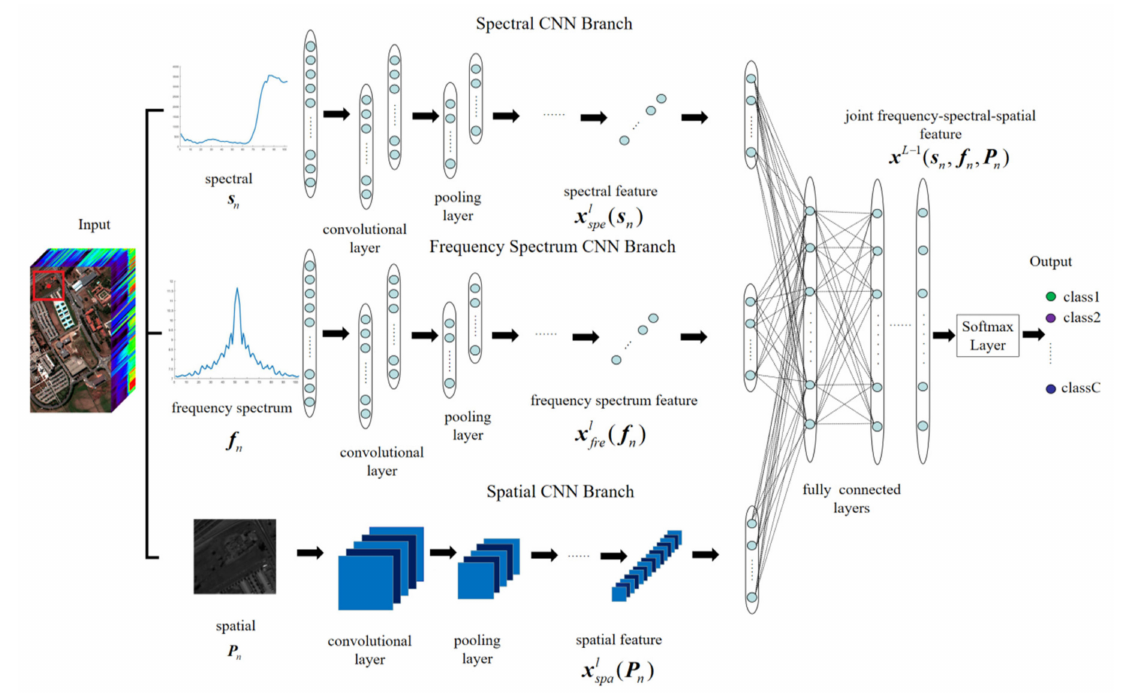
Figure 2. Architecture of proposed three-branch CNN